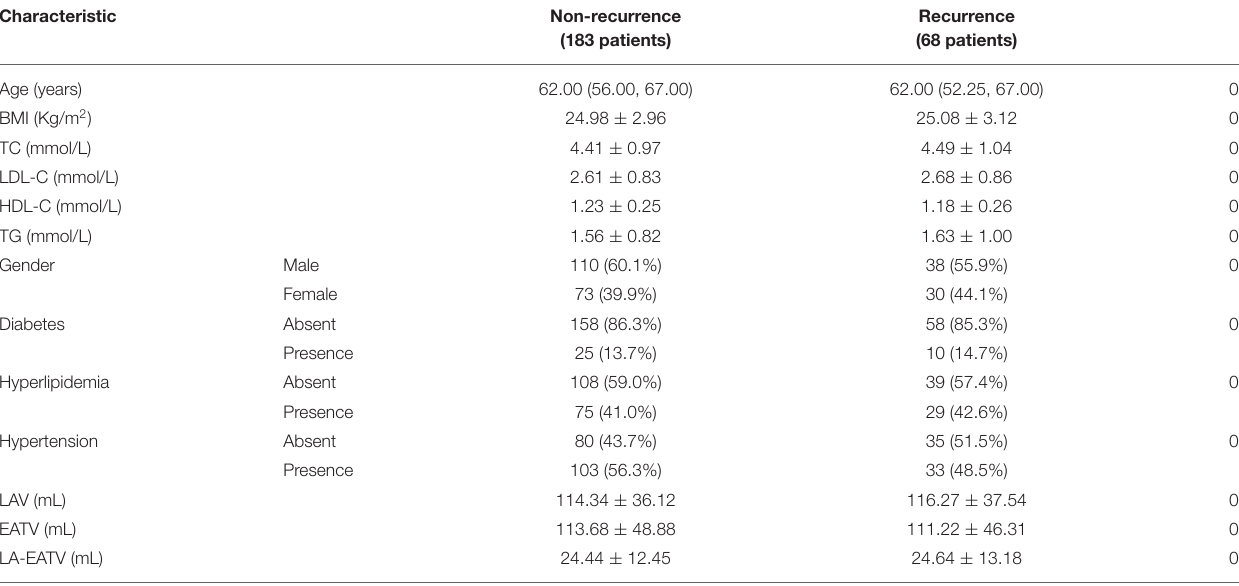
TABLE 3 | Univariate analysis of clinical characteristics and morphological parameters in AF non-recurrence and recurrence training cohorts.